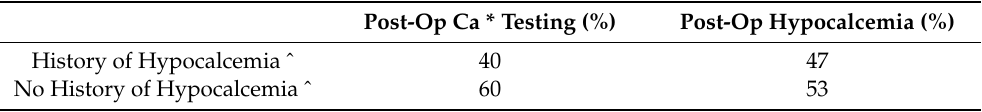
Table 2. Percentage of postoperative testing and postoperative hypocalcemia with respect to prior